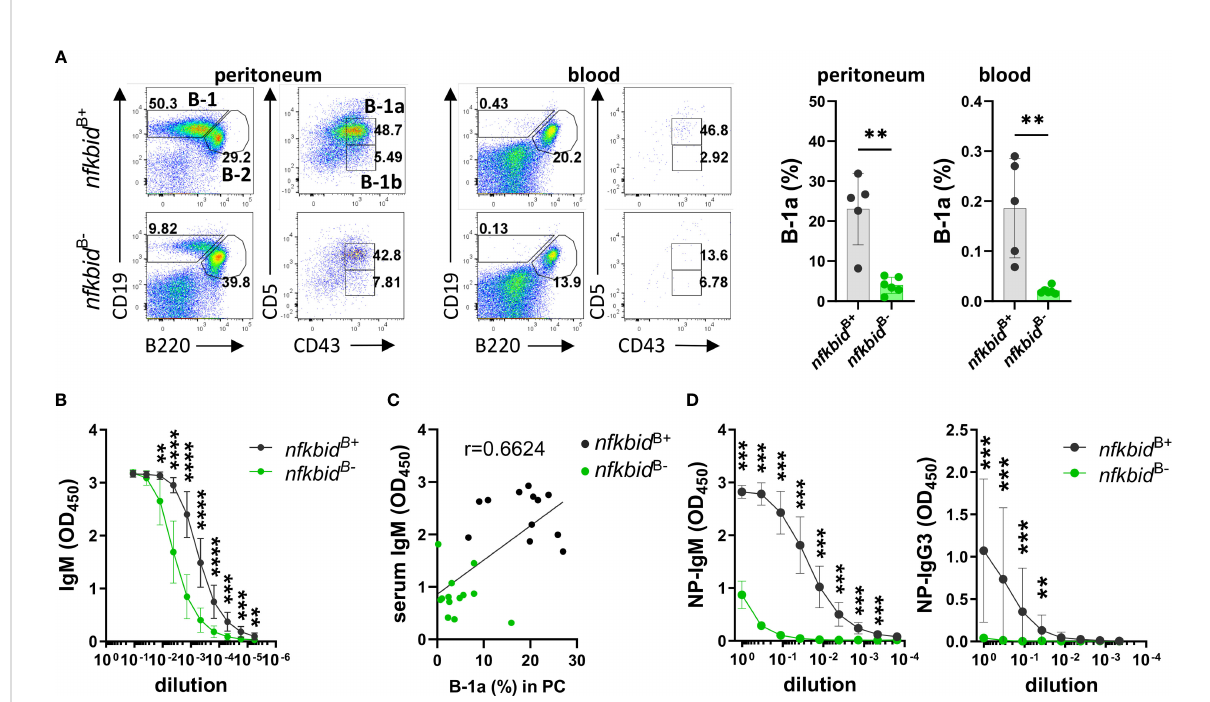
FIGURE 3 Reduced B-1a B cell compartment and TI immune response in I k BNS conditional knock-out mice. (A) Representative fl ow cytometry plots showing gating strategy for CD19 + B220 lo CD5 + CD43 + B-1a cells in peritoneal cavity (PC) and blood (left panel). Numbers adjacent to gates indicate cell frequencies in the parent population. Frequencies of B-1a cells in peritoneal cavity and blood (right panel). Bars and error bars represent mean ± SD. (B) Natural serum IgM levels. Graph lines and error bars indicate mean ± SD. (C) Correlation between serum IgM levels and frequencies of B-1a cells in peritoneum. Data are representative of three independent experiments with 3-13 mice per group for each experiment. (D) Anti-NP IgM and IgG3 antibody production in serum from mice 7 days after i.p. immunization with 50 µg NP-Ficoll. Graph lines and error bars indicate mean ± SD. Data are representative of two independent experiments with 3-7 mice per group. ** P ≤ 0.01, *** P ≤ 0.001, and **** P ≤